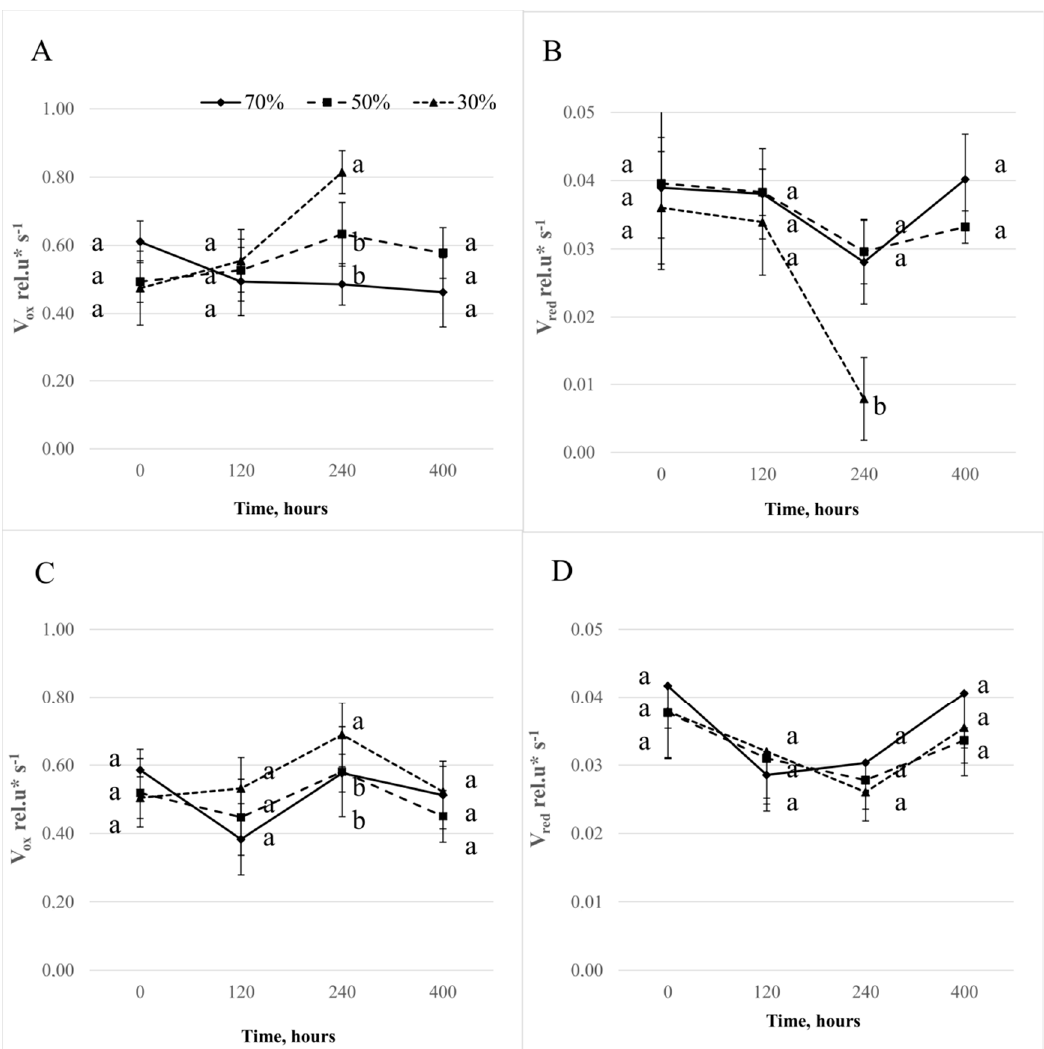
Figure 7. Relative rates of reaction centers of PS I (P700) oxidation ( A , C ) and P700 + re-reduction ( B , D ) ± S.D. calculated from the MR820 signal of Roadrunner (A,B) and Nira (C,D) under different field water capacities of soil (50 and 30% FWC) and times (0, 120, 240, and 400 h after stress application). Relative units. Mean values within a term marked by the same letter did not show significant differences ( p < 0.05, n = 6).